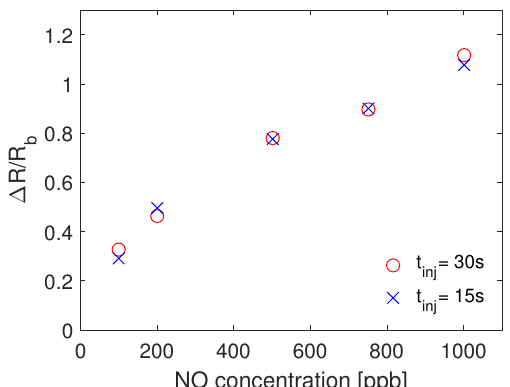
Figure 7. The mean of the response of the sensor for different concentration of NO when t inj = 15 s and t inj = 30 s. The retraction time in both cases is t ret = 3